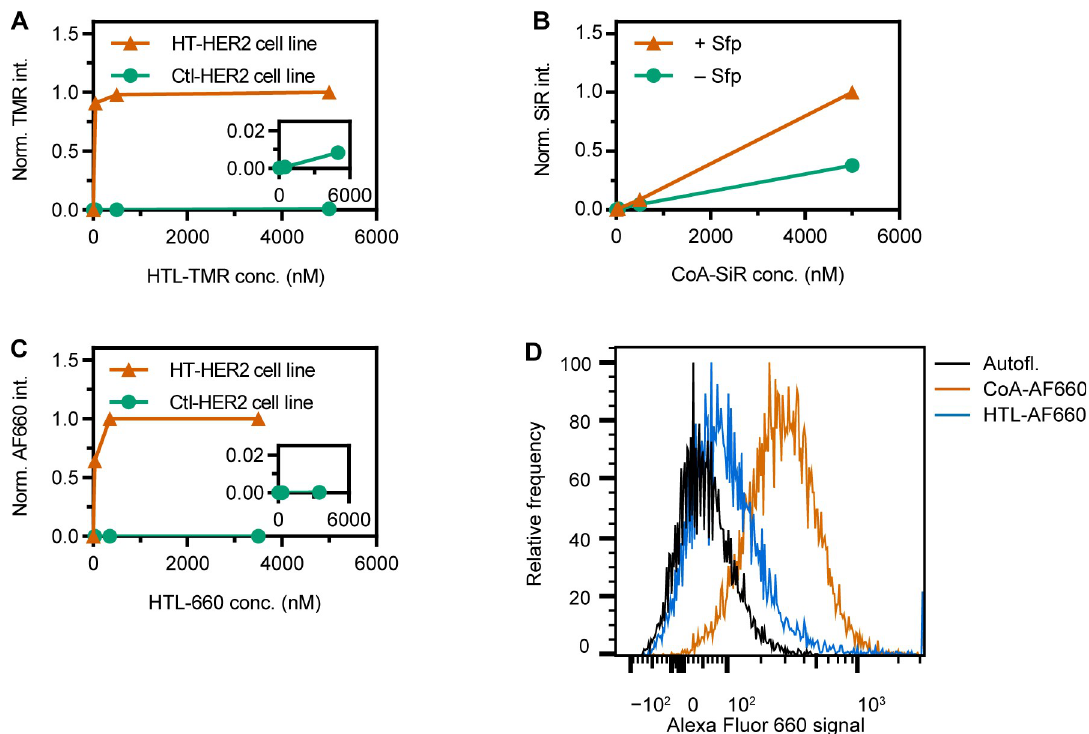
Fig 3. Comparison of PPTase and HaloTag (HT) labeling. (A) Using cell-permeable HTL-TMR, saturation is reached by labeling for 15 min with nanomolar concentrations with high specificity (vermillion curve), as very low signal is found in the absence of HT fusion (bluish green curve). (B) In contrast, saturation is not reached by 5 μ M of cell-permeable CoA-SiR, even after 30 min incubation with 1 μ M Sfp enzyme (vermillion), with about 30% of the signal being non-specific (in the absence of enzyme, bluish green). (C) A HaloTag ligand (HTL) based on Alexa Fluor 660 results in extremely low non-specific signal (absence of HaloTag, inset, bluish green), while the kinetics are only slightly less favorable than those for HTL-TMR (vermillion). (D) Flow cytometry of HEK 293 cells (no HT, no Sfp enzyme) (black), compared with the same cells after non-specific labeling after 15 min incubation with 15 μ M of the respective HTL (blue) or CoA derivative